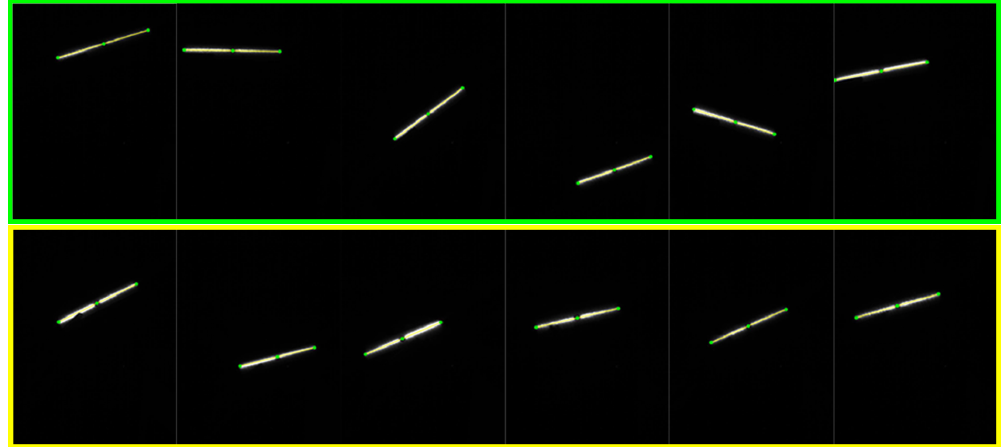
Figure 8. The images used for the LTS calibration and test.